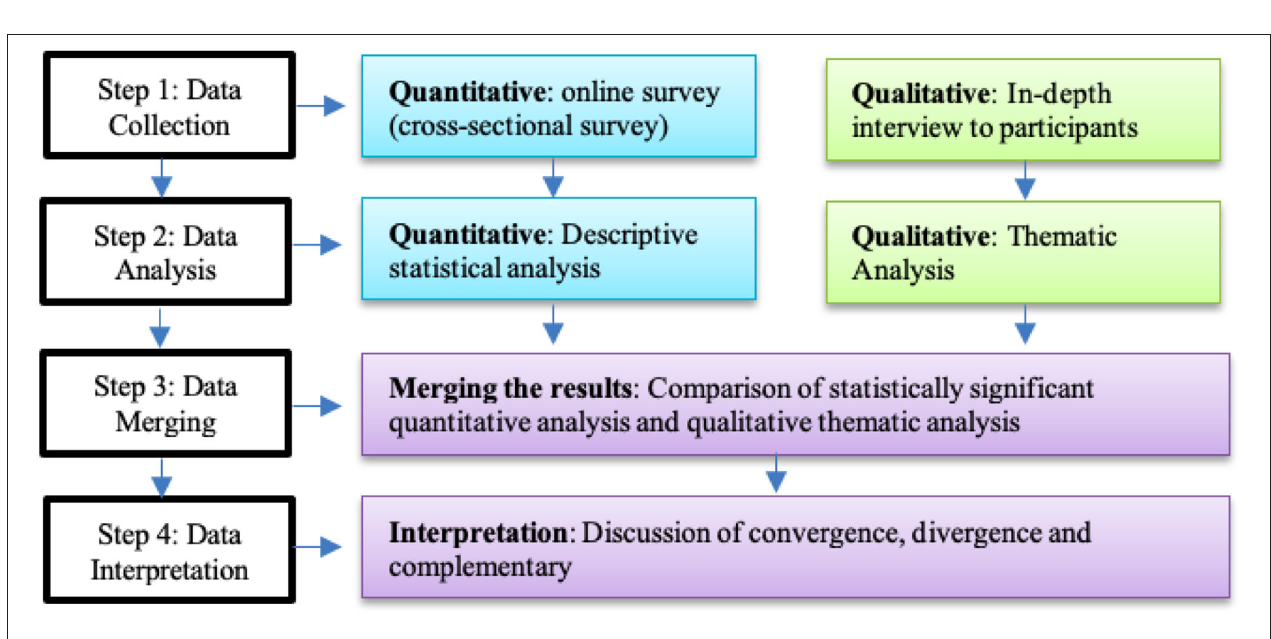
FIGURE 2 | The mix-method flow chart of the